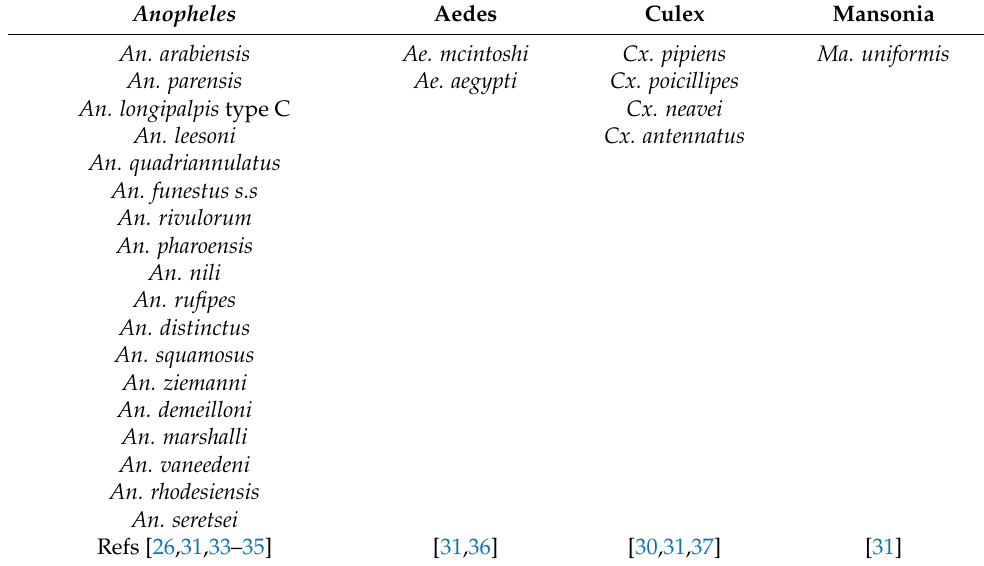
Table 1. Identified mosquito species in Botswana belonging to genera Anopheles , Aedes , Culex and Mansonia .